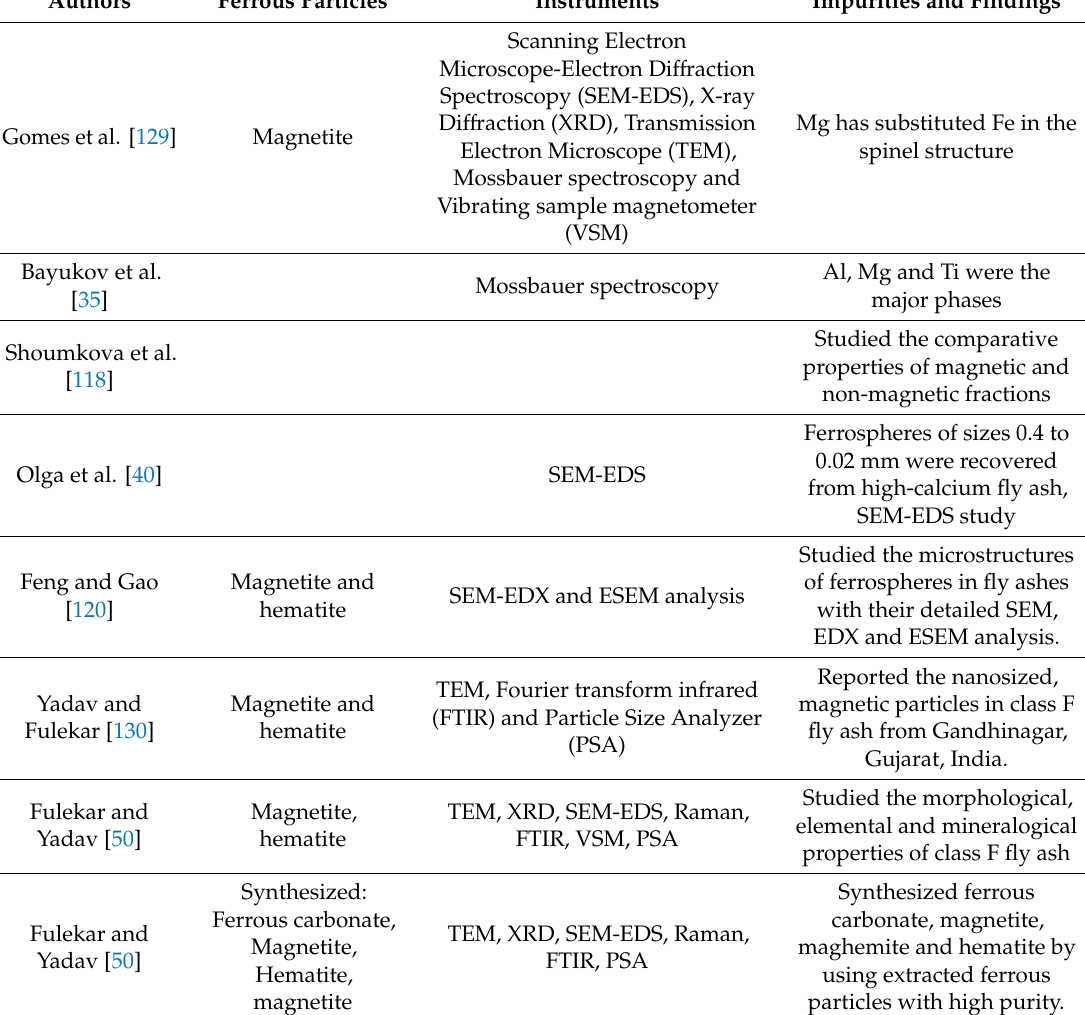
Table 2. Ferrous fractions, their properties, and extraction from fly